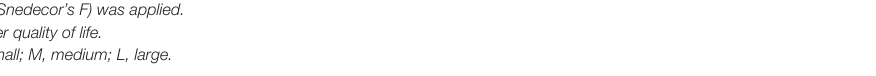
TABLE 3 | Mental health (HADS and BDI-II) of non-alcoholic fatty liver disease (NAFLD) patients based on non-alcoholic steatohepatitis (NASH; absence and presence) and social support level (high and low) variables. NASH: Social support level: M a (SD) M a